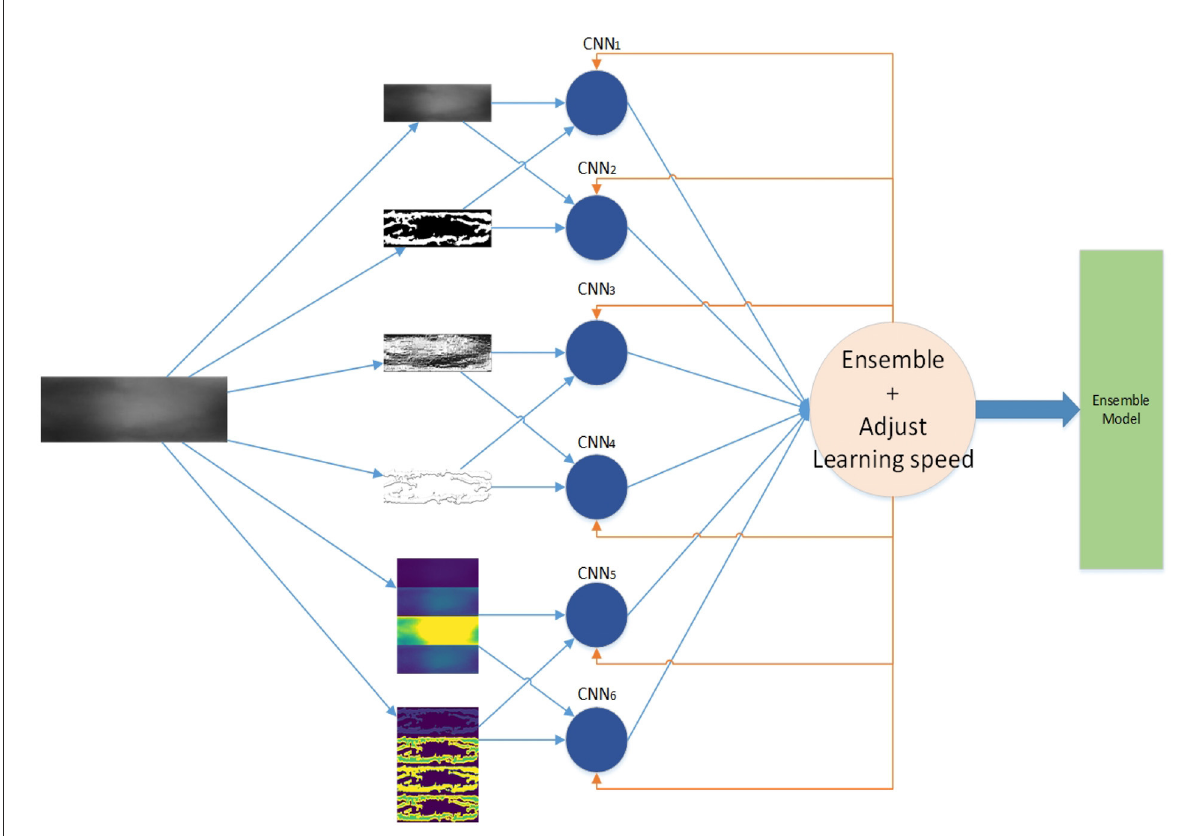
FIGURE10 Training structure of the shared learning with adjust learning speed